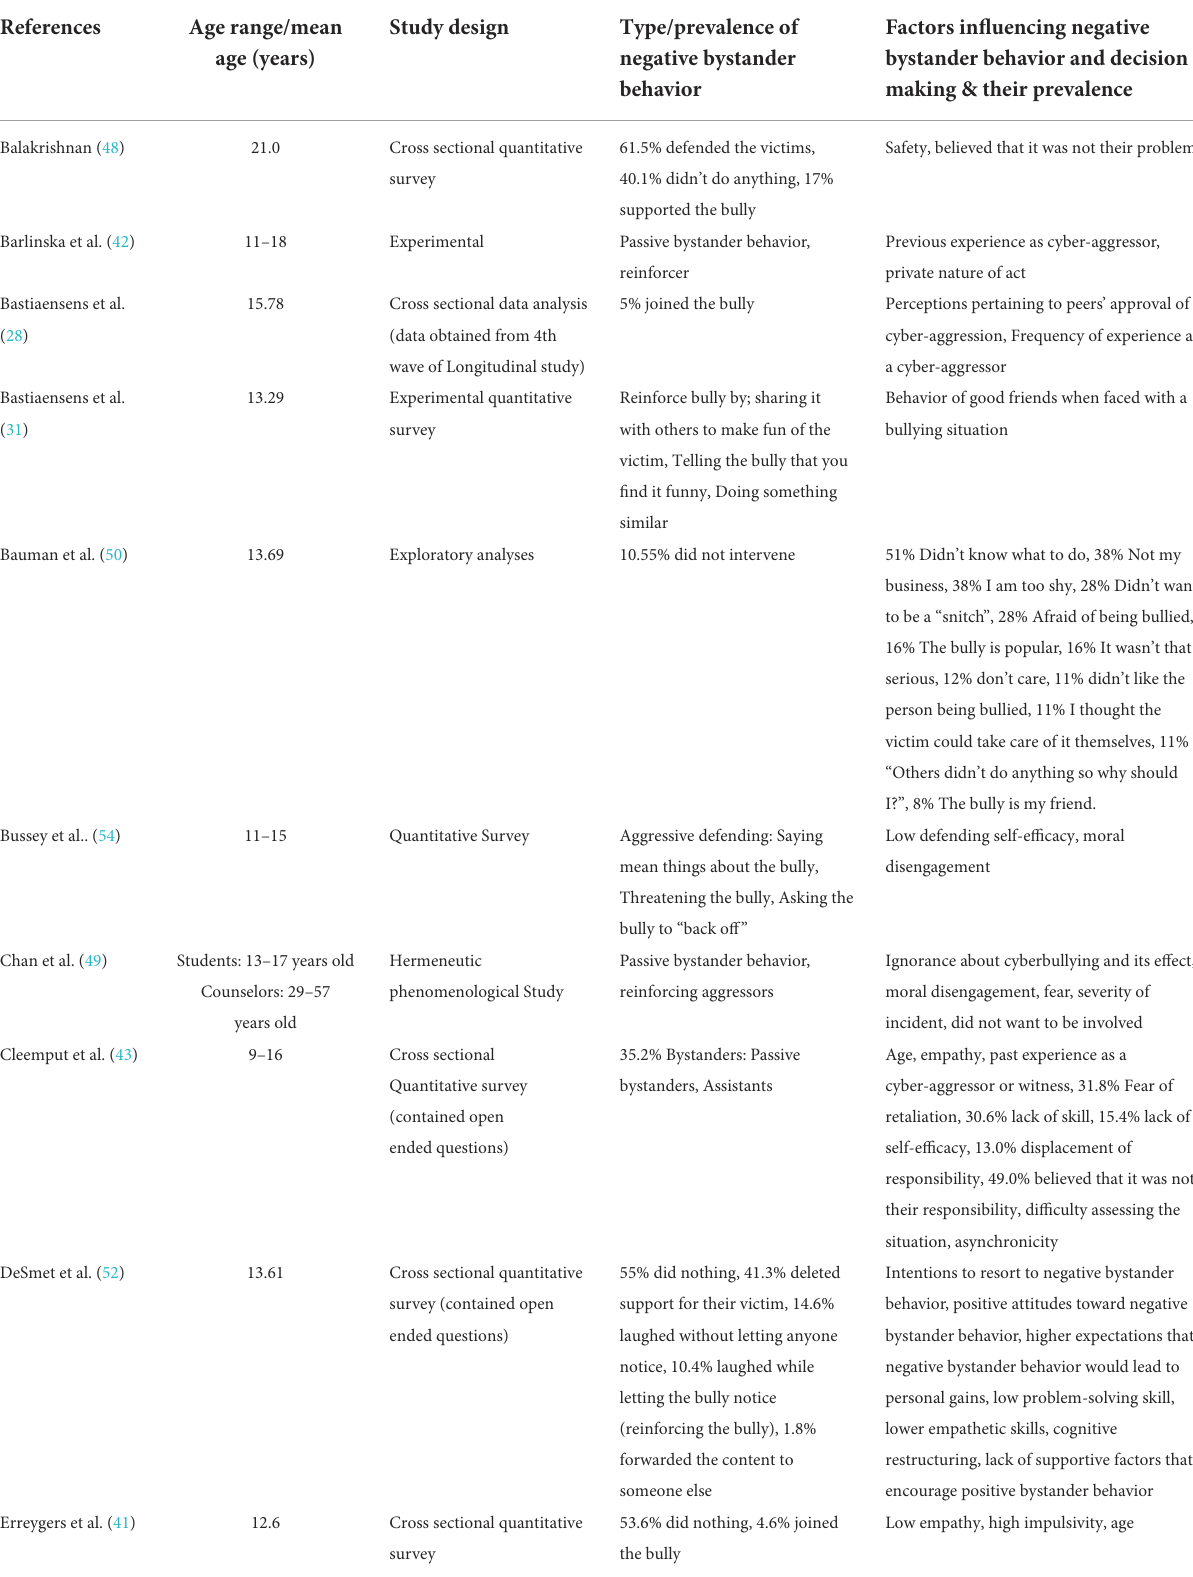
TABLE 2 Articles included in the